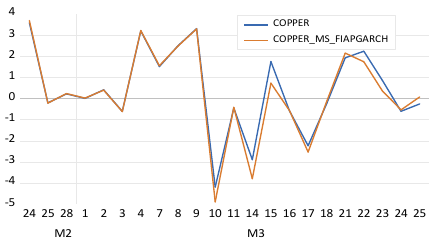
Figure 2. Copper, MS−FIAPGARCH.